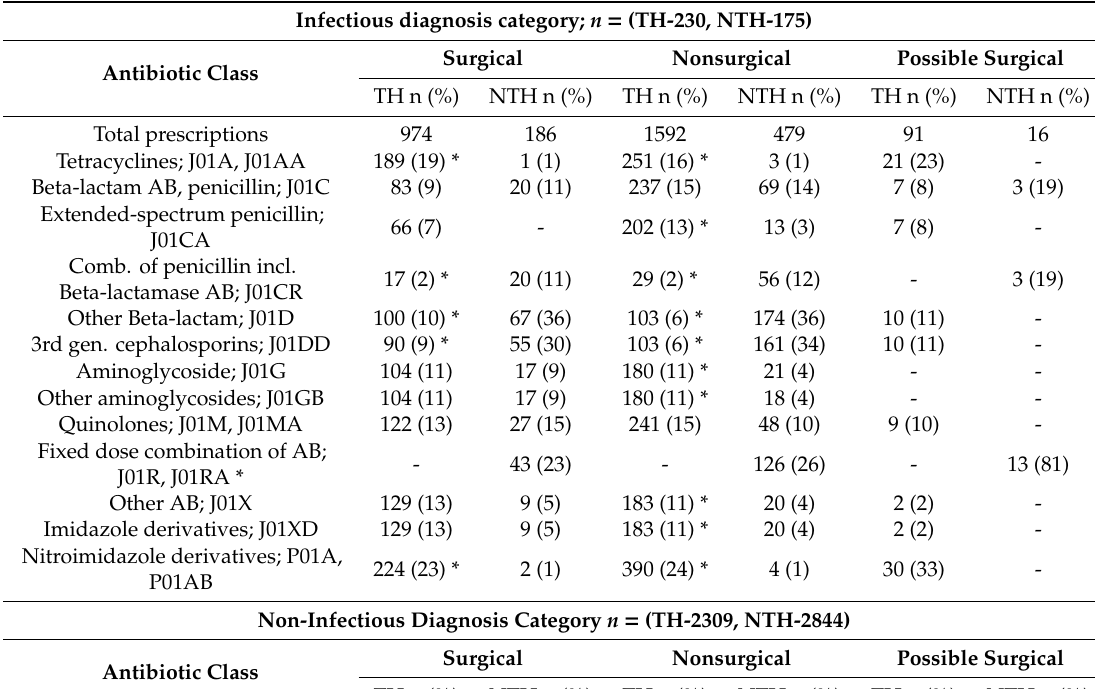
Table 3. Classes and subclasses of prescribed antibiotics at the category and group level in the Obstetrics and Gynaecology departments of two private-sector hospitals, the TH and the NTH, in Central India. Infectious diagnosis category; n = (TH-230,